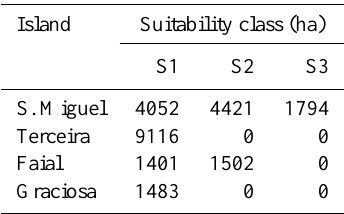
Table 3. Areas (ha) of the suitability classes for viticulture in the Azores